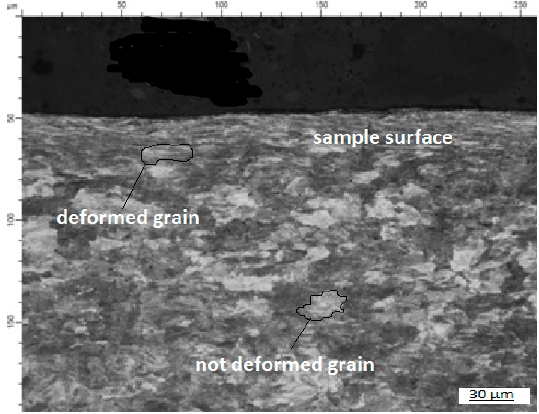
Figure 3. Microstructure of wire drawn (series of the experiments 3.3, see Table 2) ×500.